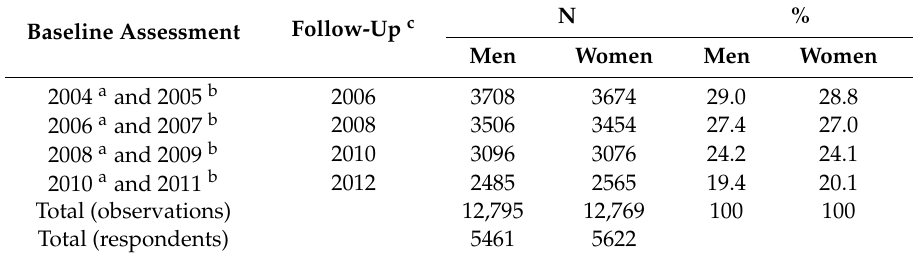
Table 1. Description of baseline and follow-up data (German Socio-Economic Panel